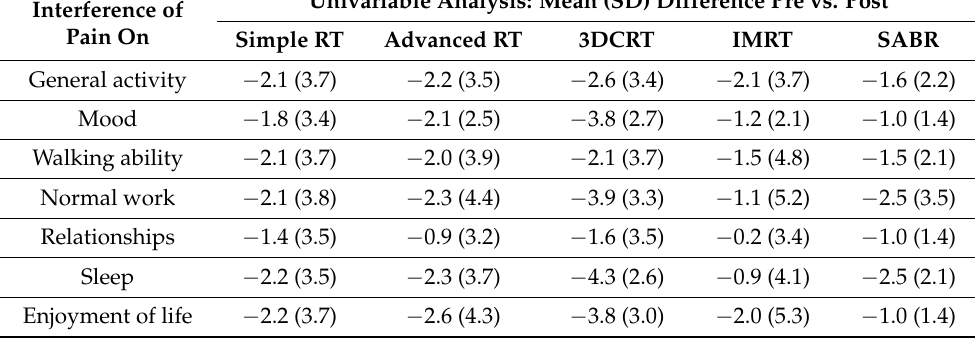
Table 5. Univariable and multivariable comparison of pain interference on QoL by simple vs. advanced RT technique for